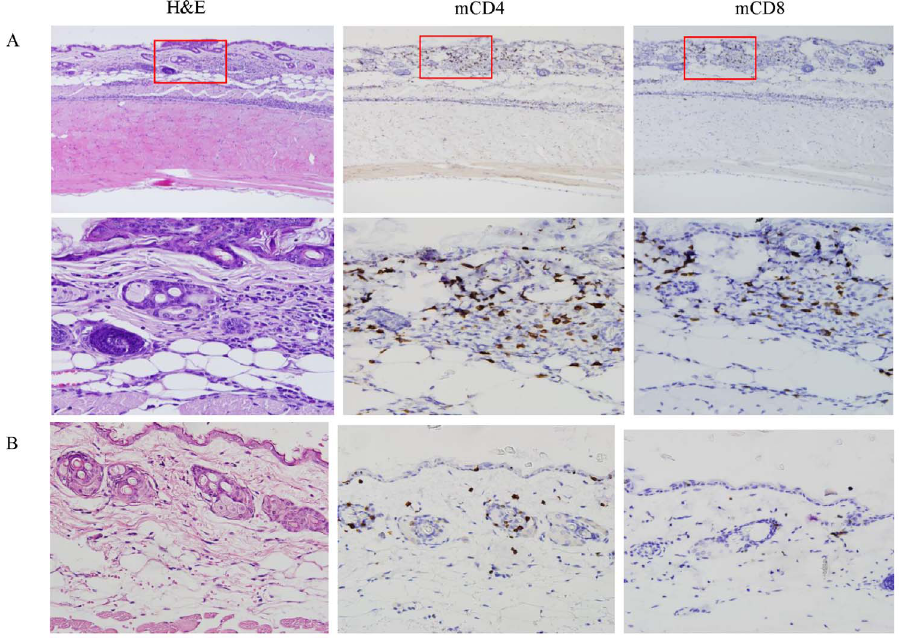
Figure 6. Histologic features of abdominal skins from (A) midge-sensitized and (B) controlled mice. The skin sections were obtained 48 hours after performing intra-dermal skin test and were stained with H and E or immuno-stained with anti-mouse CD4 (mCD4) or CD8 (mCD8) polyclonal antibodies. Magnification: A, upper, 6 100; lower and B, 6 400.